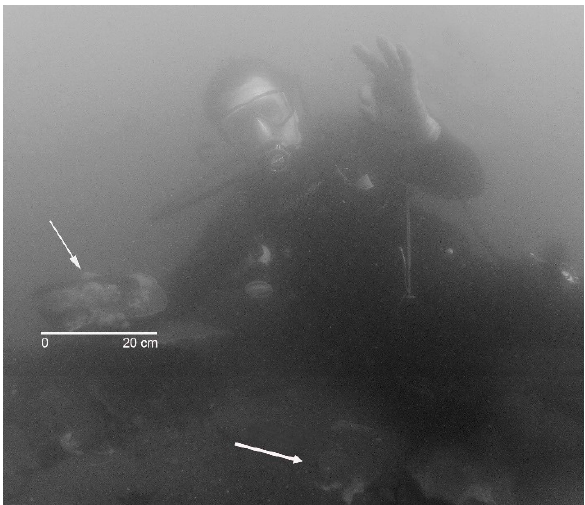
Figure 3. Scuba diving recovery of turtle peripherals (NJSM GP23413) described in this study. The arrow below the diver points to large coquina blocks of the lag deposit eroded and transported directly downstream from the adjacent outcrop exposure depicted in Figure 2. Scale Bar = 20 cm.